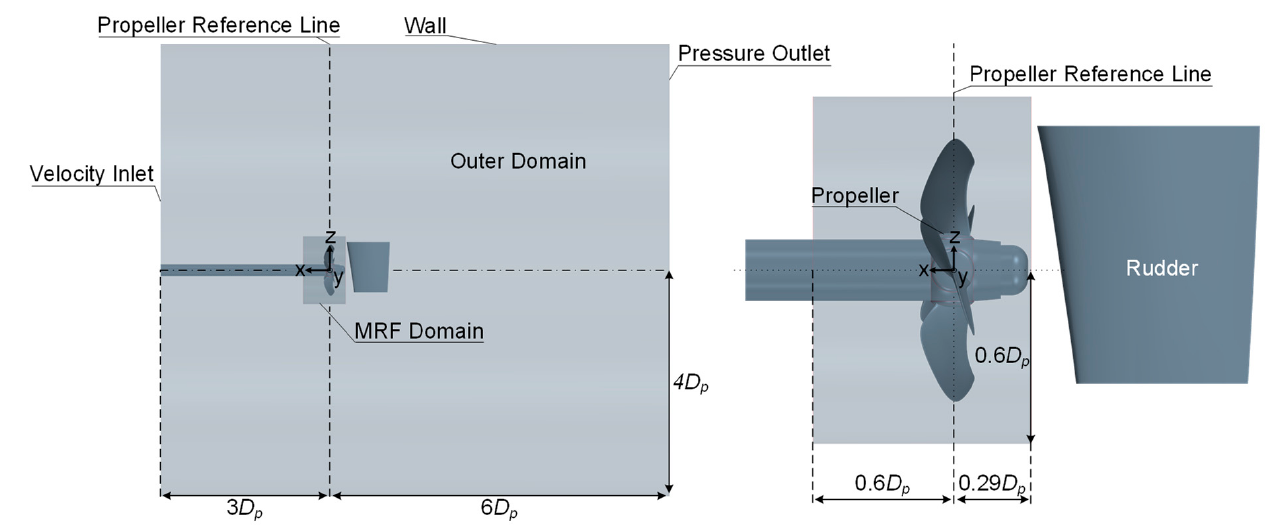
Figure 3. The entire computational domain ( left ); the zoom-in of MRF domain and rudder ( right ).